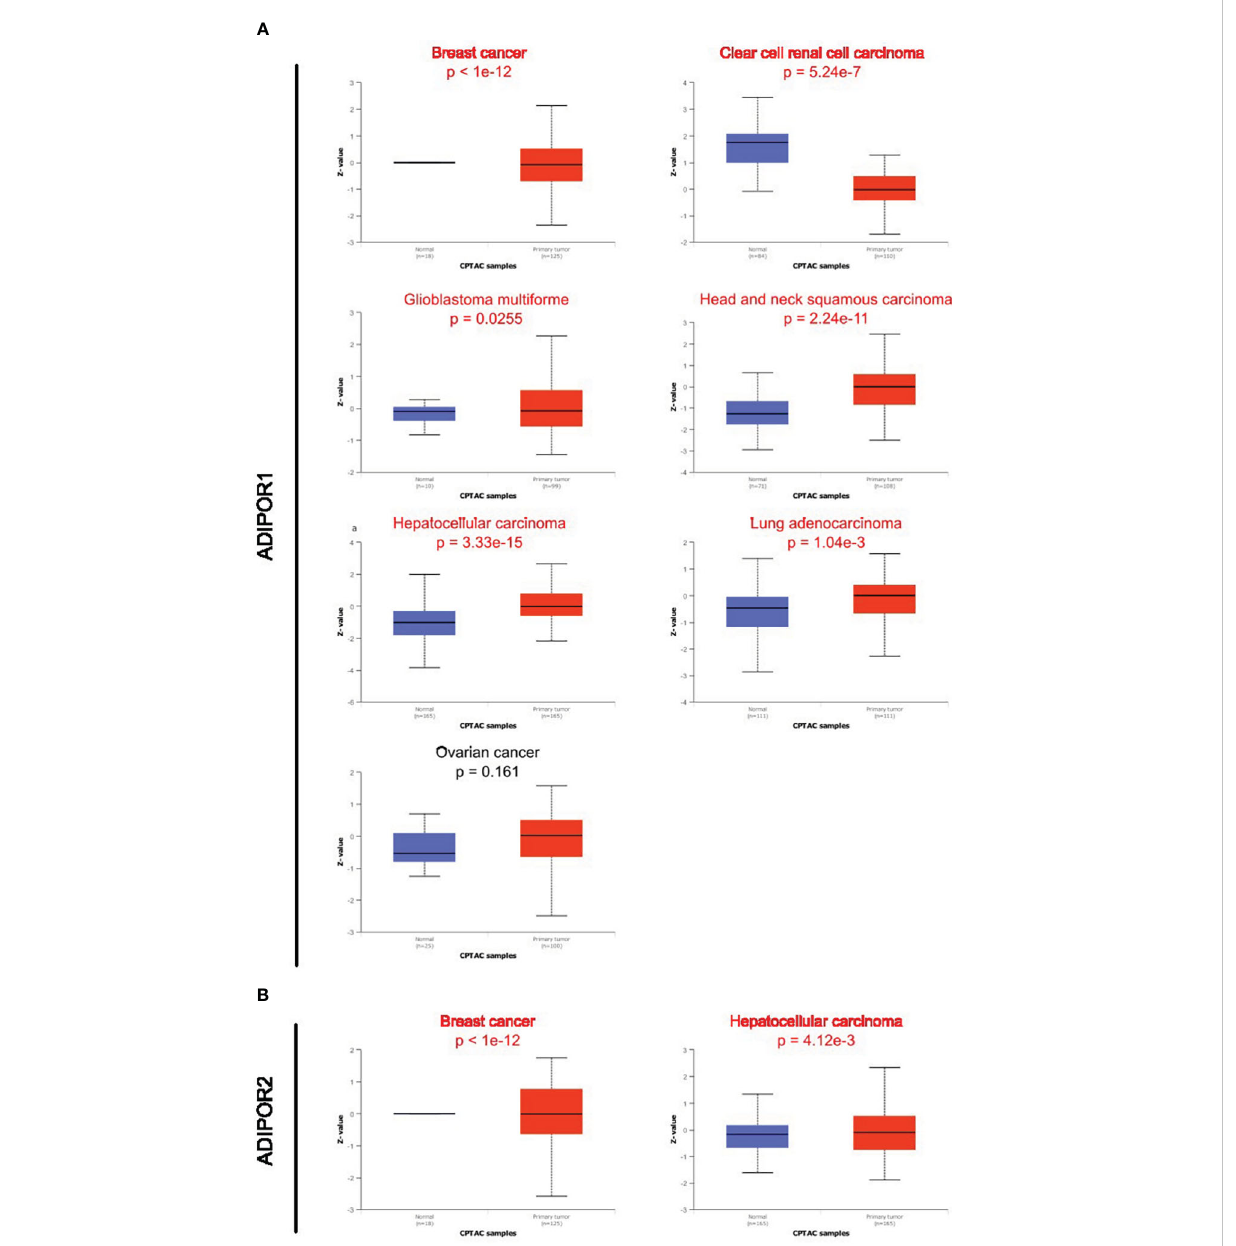
FIGURE 3 The protein abundance of ADIPOR1 and ADIPOR2 in cancers. (A) The ADIPOR1 protein abundance in UALCAN database. (B) The ADIPOR2 protein abundance in UALCAN